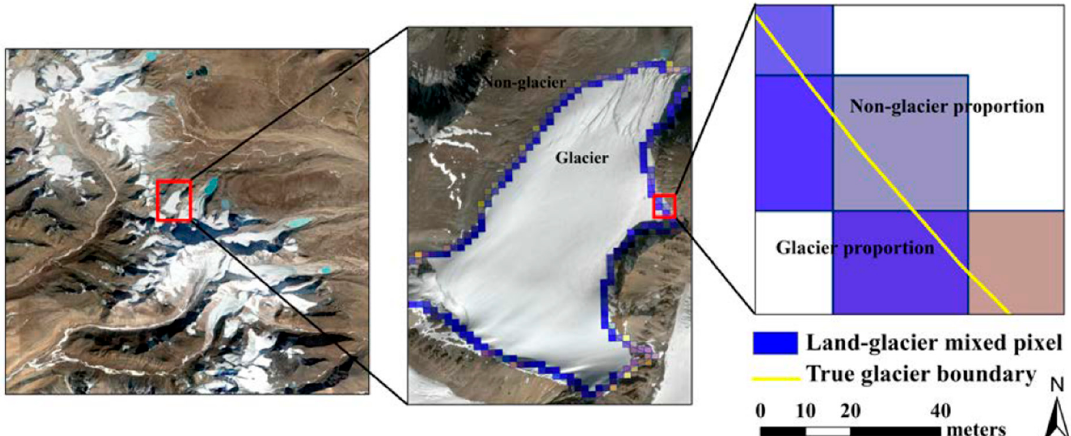
Figure 4. Edge pixels around a fraction of study region I showing mixed pixels between glacier and non-glacier (high spatial resolution image accessed through Google Earth).